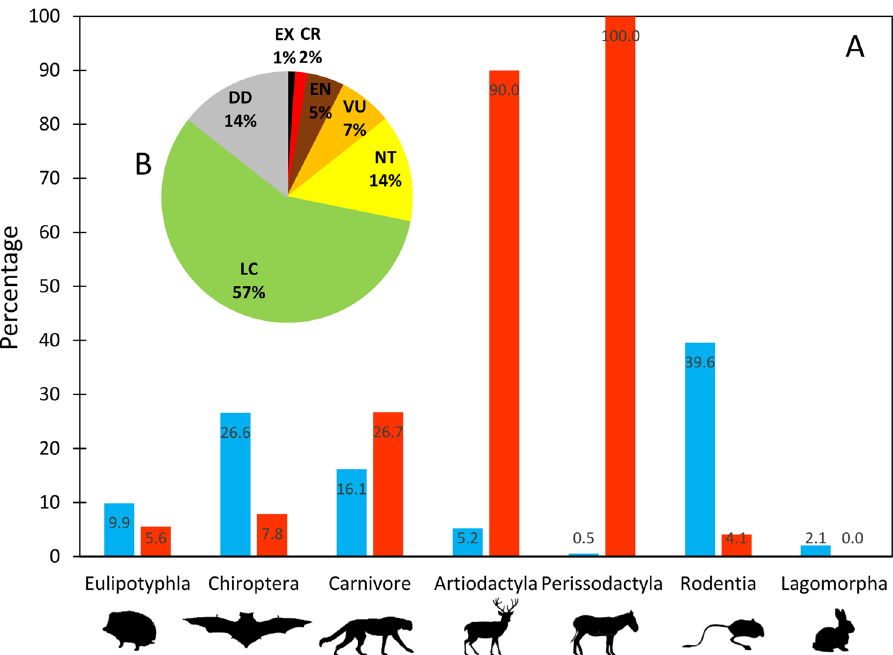
Figure 3. ( A ) Blue bars show the percentage of Iranian terrestrial mammal species in different orders and red bars show the percentage of orders listed as threatened at national level. ( B ) The pie chart shows the percentage frequency of species in each of the Iran Red List categories: Data Deficient (DD), Least Concern (LC), Near Threatened (NT), Vulnerable (VU), Endangered (EN), Critically Endangered (CR), and Extinct